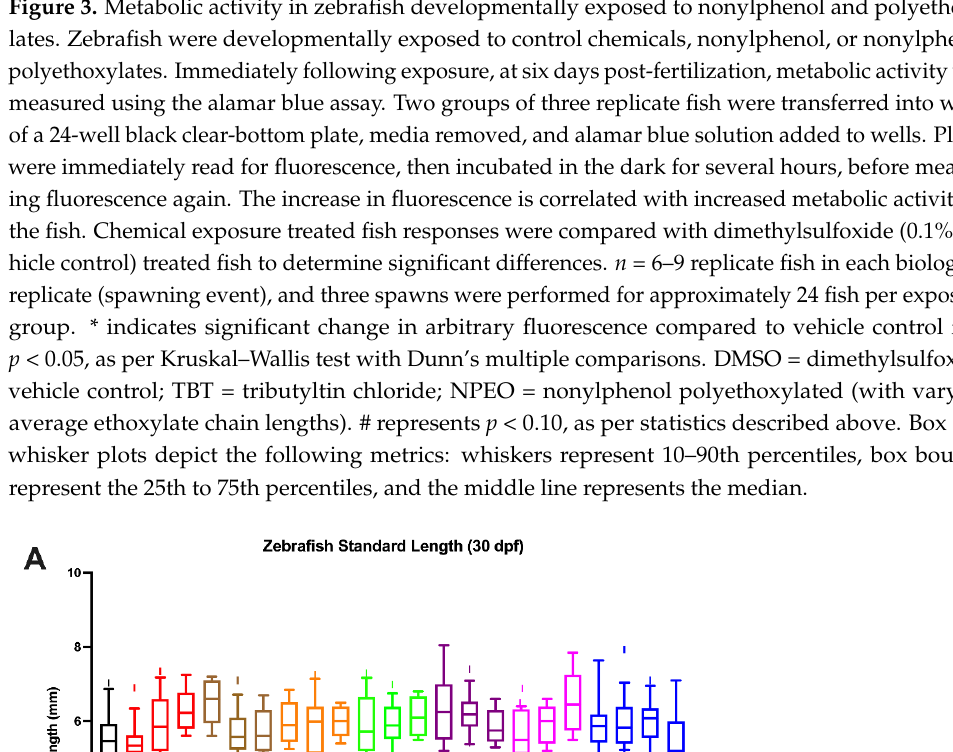
Figure 4. Growth trajectories in zebrafish developmentally exposed to nonylphenol and polyethox- ylates. Zebrafish were developmentally exposed to control chemicals, nonylphenol, or nonylphenol